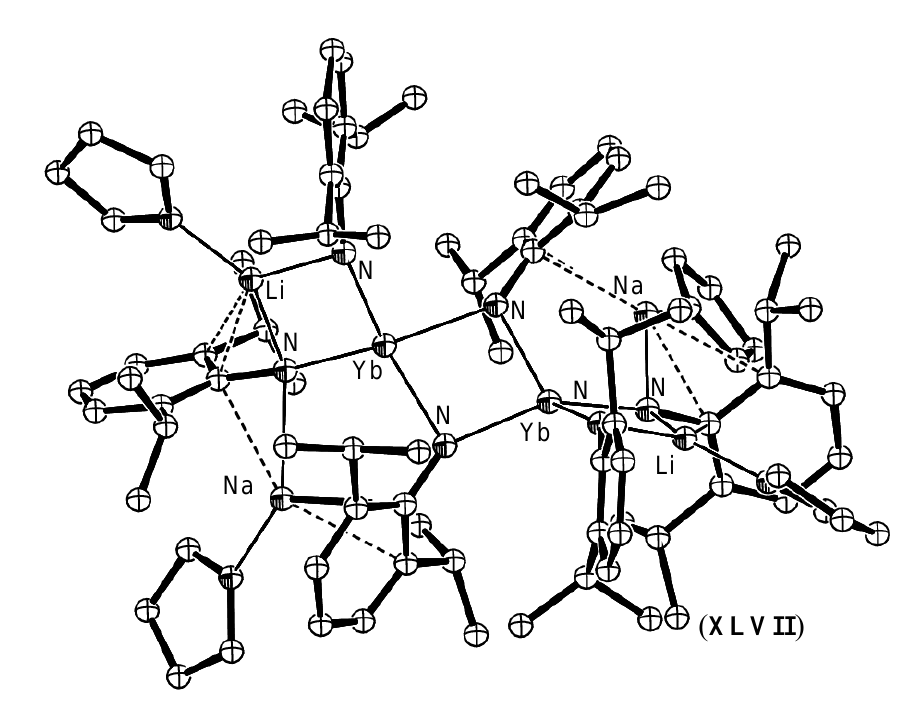
Figure 18. Ytterbium imide complex XLVII resulting from deprotonation by n -BuLi [66]. Figure generated from CCDC obtained coordinates. Atoms of arbitrary size. H atoms are excluded for clarity. Amido H atoms were inferred but were not